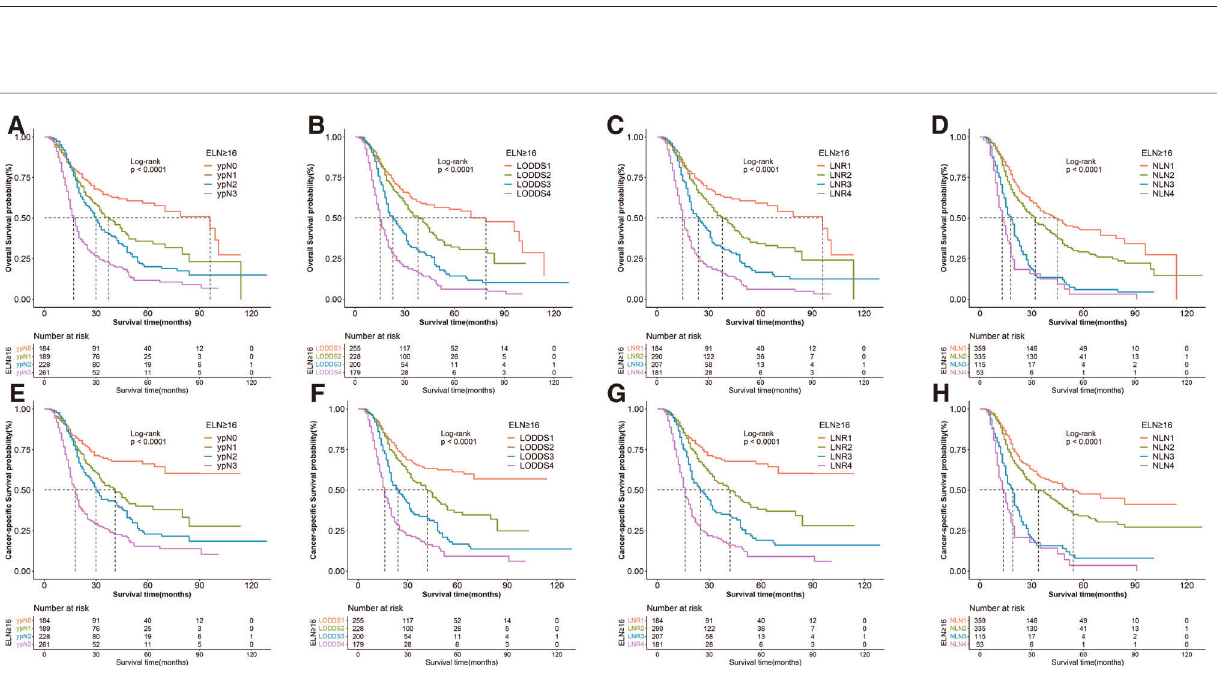
FIGURE 6 | Kaplan – Meier survival curves of OS according to ( A ) ypN, ( B ) LODDS, ( C ) LNR, and ( D ) NLN staging system and CSS according to ( E ) ypN, ( F ) LODDS, ( G ) LNR and ( H ) NLN staging system for gastric adenocarcinoma patients after NAT with ELN ≥ 16. OS, overall survival; CSS, cancer speci fi c survival; LNR, lymph node ratio; LODDS, log odds of positive lymph node; NLN, negative lymph node; NAT, neoadjuvant